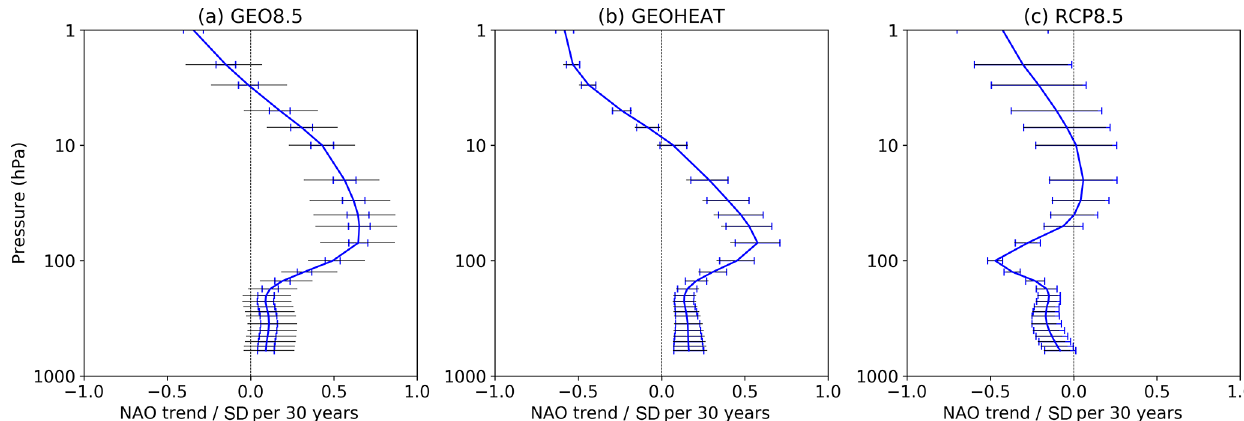
Figure 4. Vertical profile of trends in DJF zonal wind characterizing the NAO. Shown are ensemble mean linear trends in (a) GEO8.5, (b) GEOHEAT and (c) RCP8.5, with error bars showing the 95% confidence interval ( ± 2 σ/ The 5th–95th percentile range is shown by horizontal black lines. In (b) GEOHEAT and (c) RCP8.5, the confidence interval and range are essentially the same.